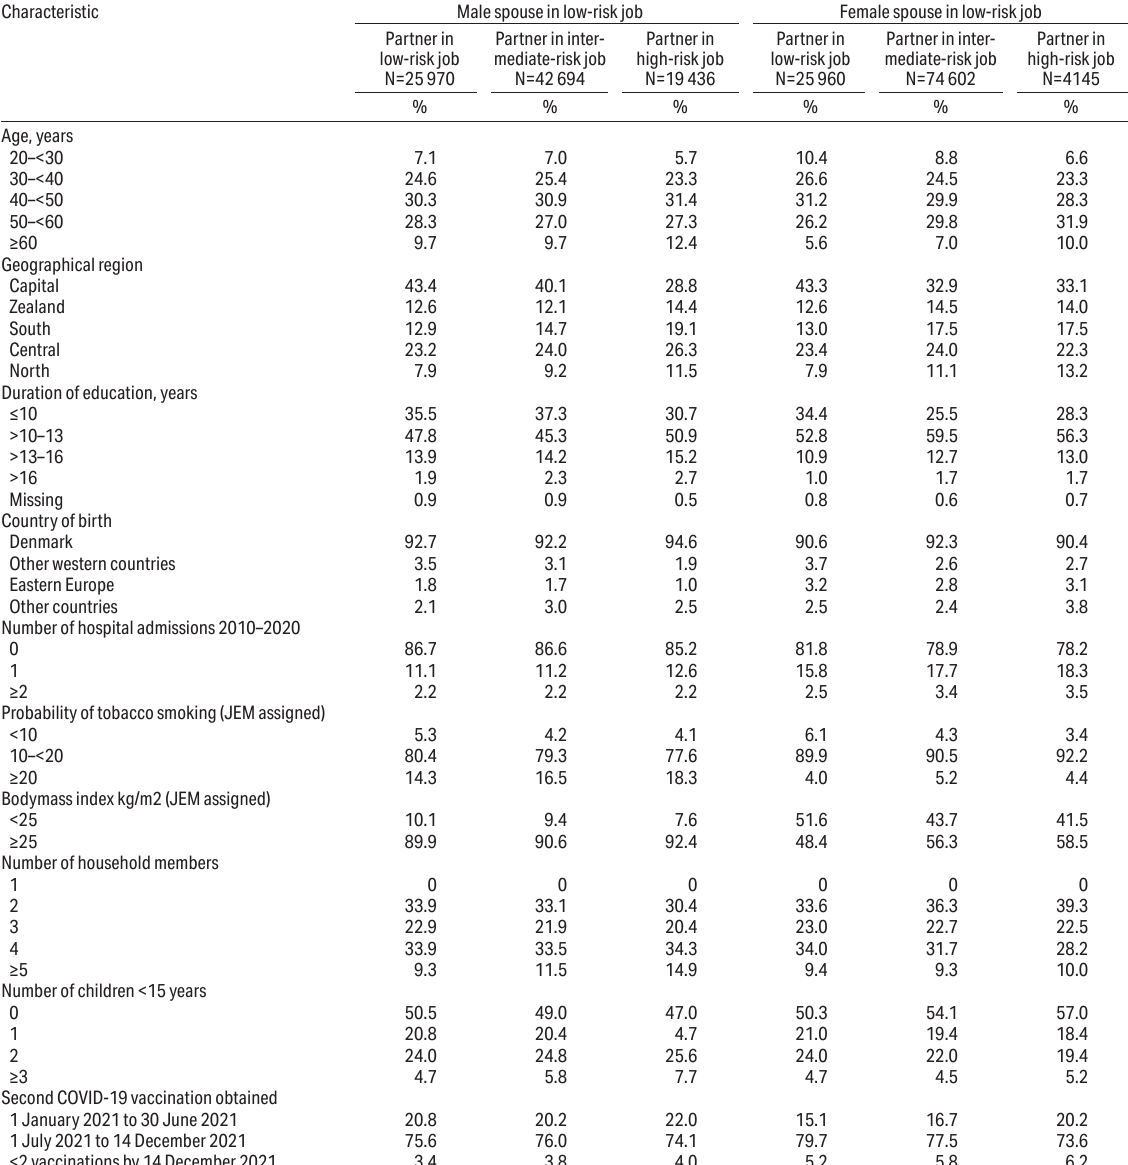
Table 1. Characteristics of male and female spouses according to risk of exposure to SARS-CoV-2 in job held by partner. Characteristic Male spouse in low-risk job Female spouse in low-risk